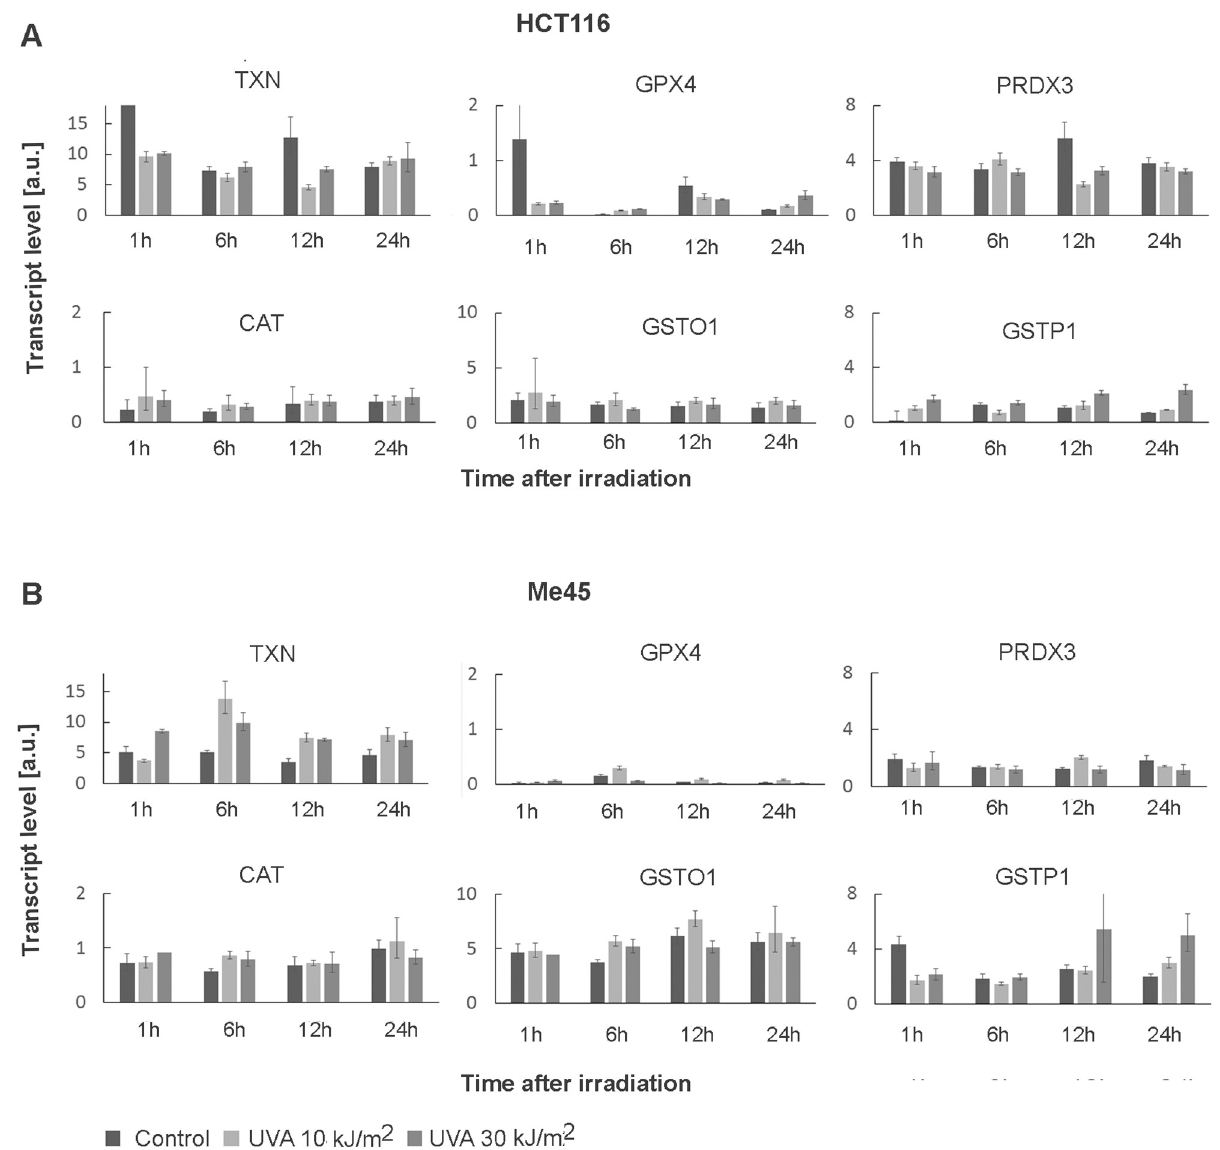
Fig 5. Changes of expression after UVA radiation (10kJ/m 2 , 30kJ/m 2 ) and control cells. Results are presented as relative level to RPL41 transcript expression with standard